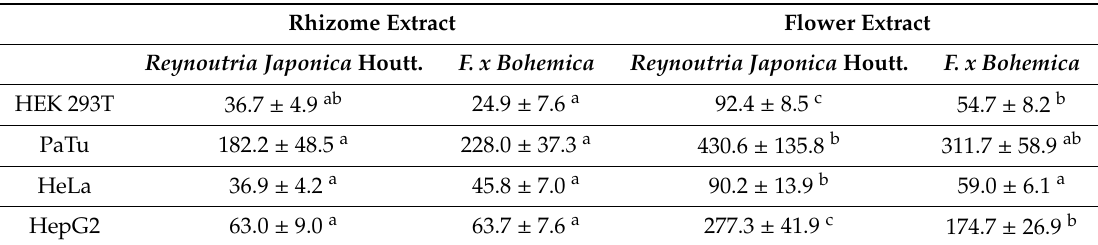
Table 1. The concentrations [ µ g / mL] that halved the viability (IC 50 ) of cancer (PaTu, HeLa, HepG2) and control (HEK 293T cell line)